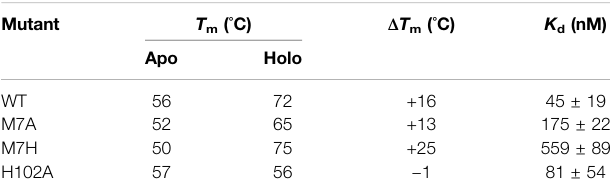
TABLE 1 | CD and binding data for Co-cyt b 562 mutants. CD spectra was obtained at 20 ° C in 10 mM phosphate buffer pH 7.5 with a protein concentration of 5 μ M and CoPPIX concentration of 20 μ M. The K d values were obtained using UV-Vis spectroscopy by titrating a stock solution of apo protein to a solution of CoPPIX of known concentration (see Methods and Supplementary Figures S1 and S2